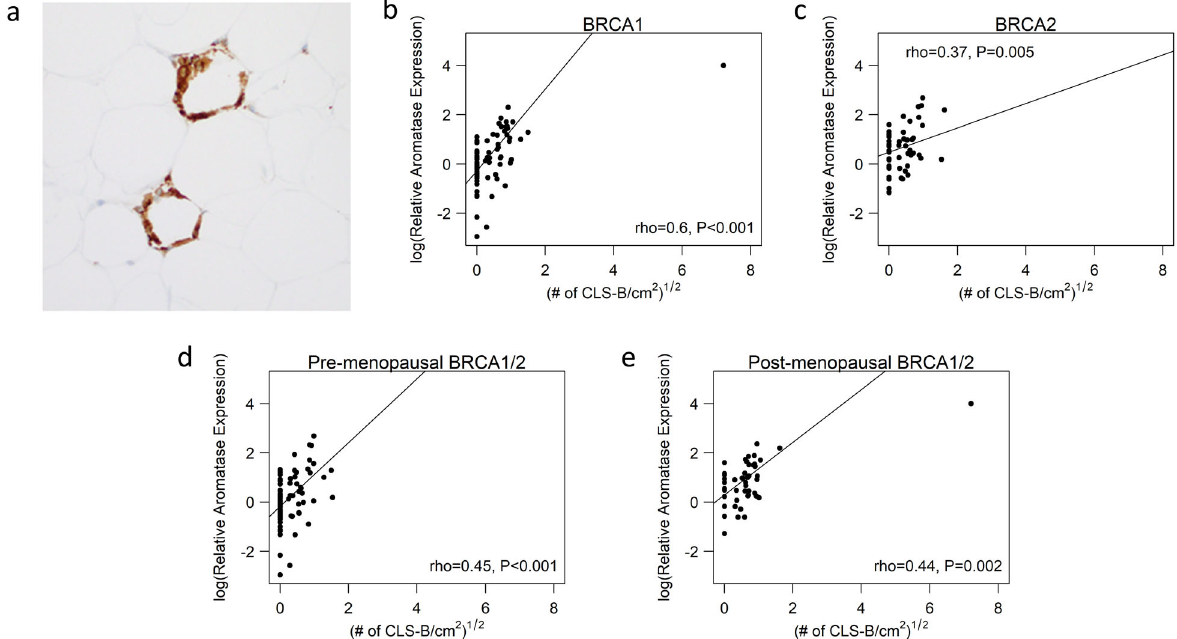
Fig. 2 Breast WATi is associated with elevated levels of aromatase. a Anti-CD68 immunostaining showing CLS-B (×200). b Relative aromatase expression by the severity of white adipose tissue in fl ammation (CLS-B/cm 2 ) in BRCA1 mutation carriers. c Relative aromatase expression by severity of white adipose tissue in fl ammation (CLS-B/cm 2 ) in BRCA2 mutation carriers. d Relative aromatase expression by severity of white adipose tissue in fl ammation (CLS-B/cm 2 ) in pre-menopausal BRCA1/2 mutation carriers. e Relative aromatase expression by